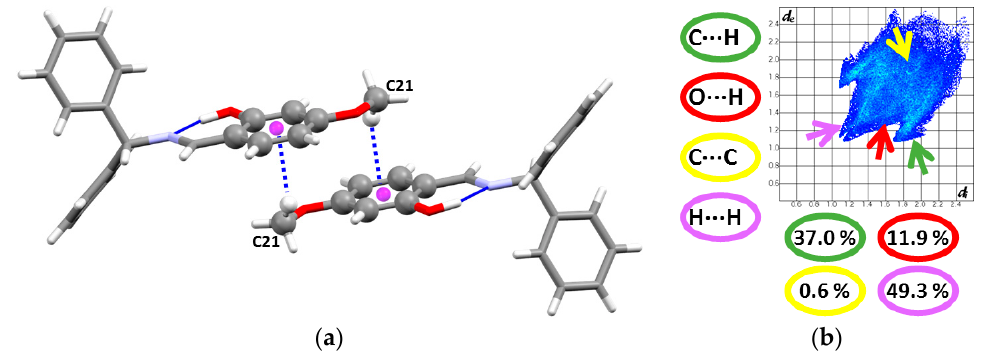
Figure 6. View of ( a ) a centrosymmetric dimer of mvanadpm molecules formed by means of C–H··· Cg (C1 to C6) contacts and ( b ) the 2D-fingerprint plot with marked corresponding regions: green arrow for C···H contacts, red arrows for O···H contacts, yellow arrow for C···C contacts and violet arrow for H···H contacts.